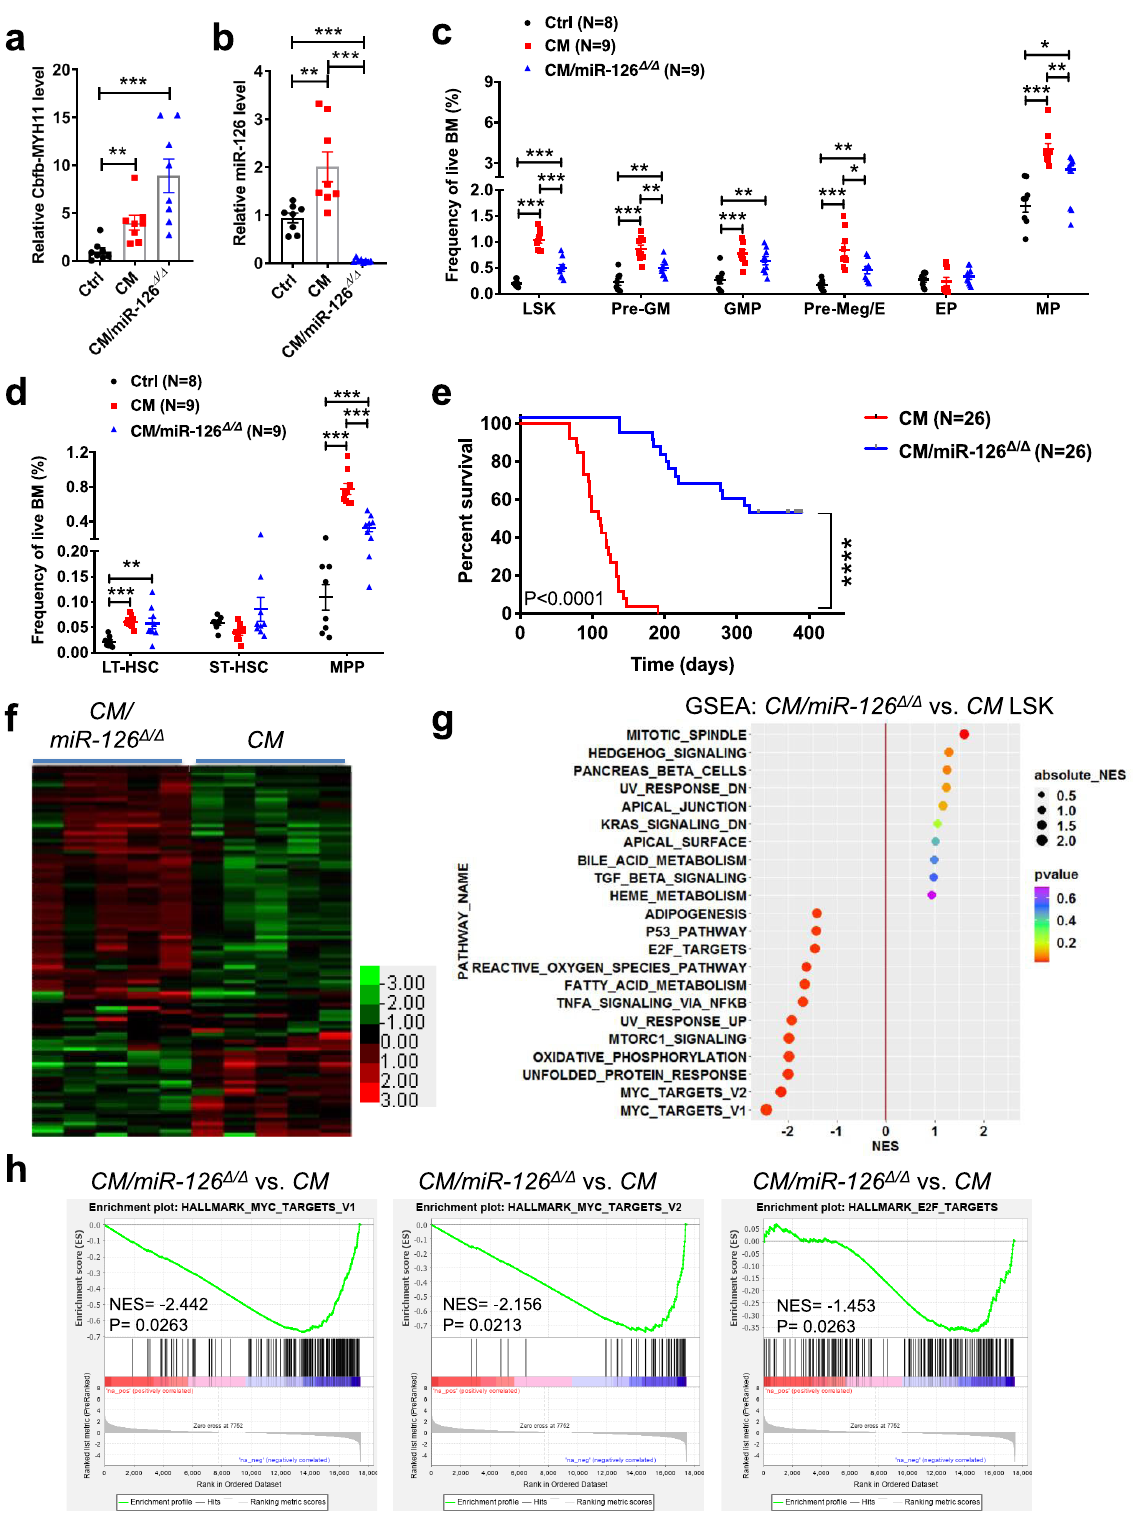
the recipients ( n = 5) of BM cells from SCR-treated group (Fig. 7g; median survival 199 days vs. 137 days; p = 0.013). Altogether, these results indicate that in vivo administration of miRisten effectively inhibits AML propagation and impedes leukemia-initiating activity of inv(16) AML